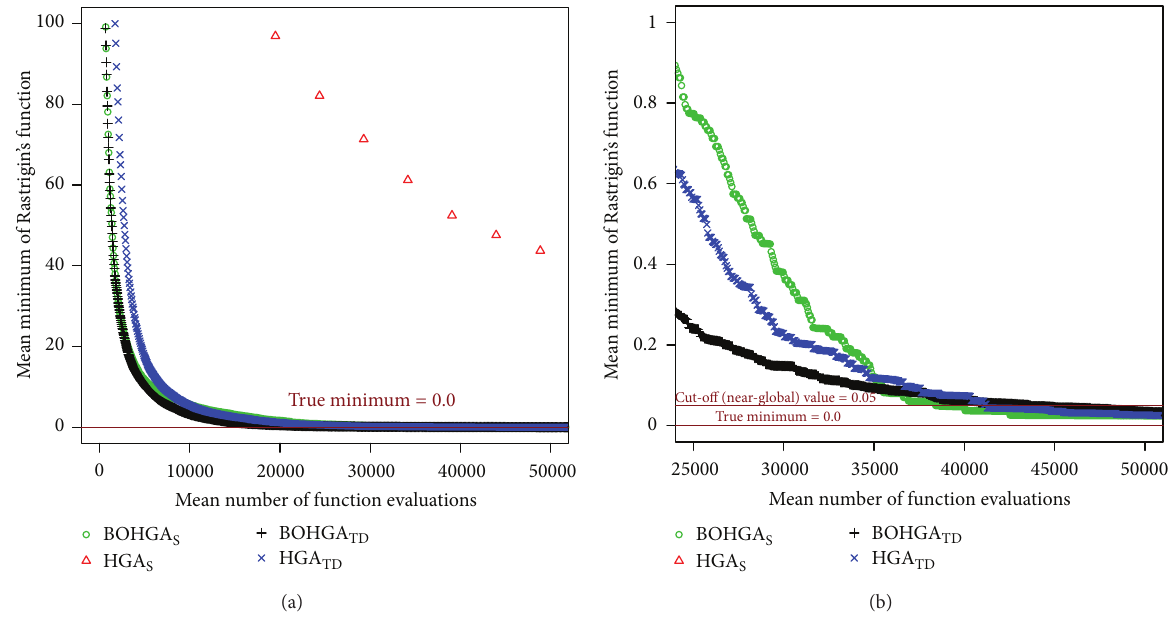
Figure 3: Best minimums of Rastrigin’s function in 20 dimensions versus number of function evaluations at each generation averaged over 100 replications of the four MA methods under the GA setting (ranking replacement, 4 crossover points, and 0.05 mutation rate). (a) Overall view in a full scale; (b) highlighted view in an expanded scale.